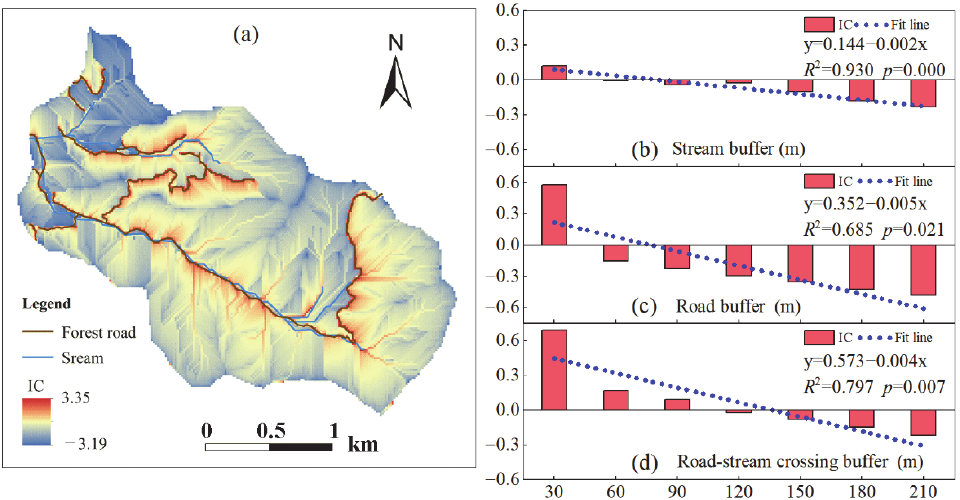
Figure 6. Spatial distribution of sediment connectivity ( a ) along different buffer distances for streams ( b ), forest roads ( c ), and road–stream crossings ( d ).